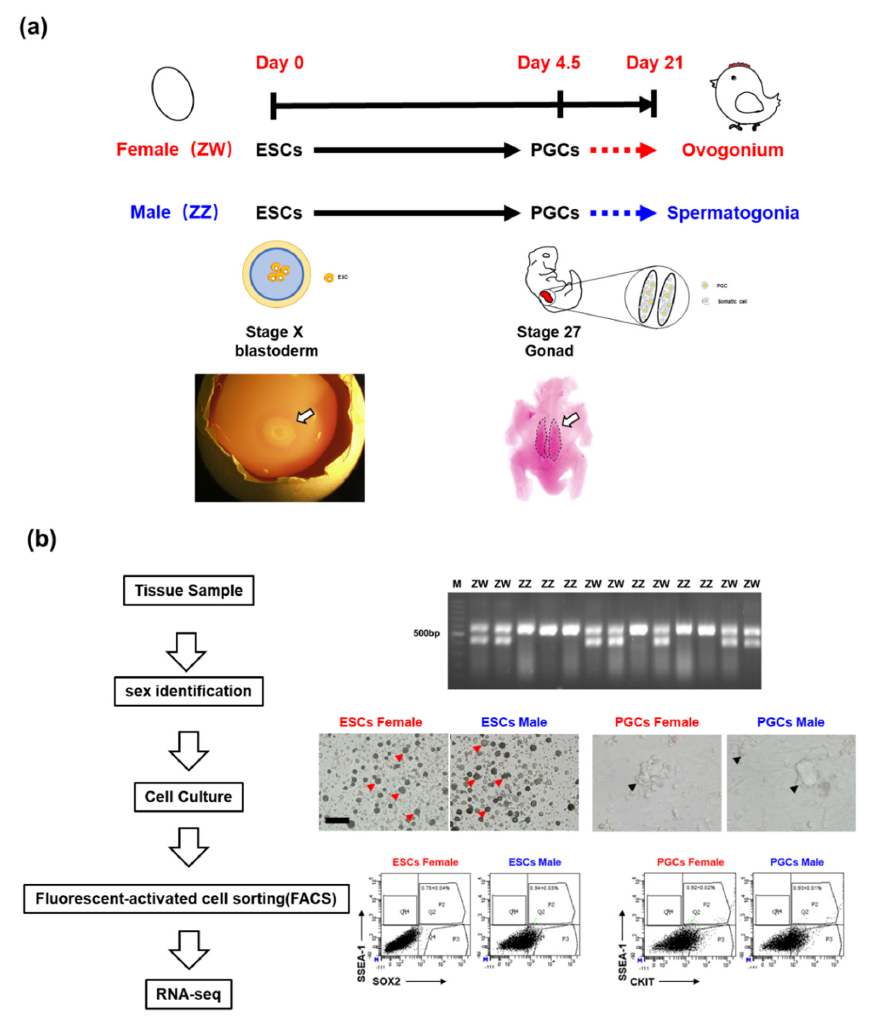
Figure 1. Experimental design and confirmation of amphoteric ESCs and PGCs in chicken. ( a ) Tissue collection of the amphoteric blastoderm (for ESCs) and gonads (for PGCs); ( b ) experimental design of RNA-seq analysis ( left ) and amphoteric ESCs and PGCs confirmation by PCR ( right-top ), morphology ( right medium , the red arrow points to typical ESCs clones, and the black arrow points to emblematic PGCs mass), and fluorescence activated cell sorter (FACS) ( right bottom